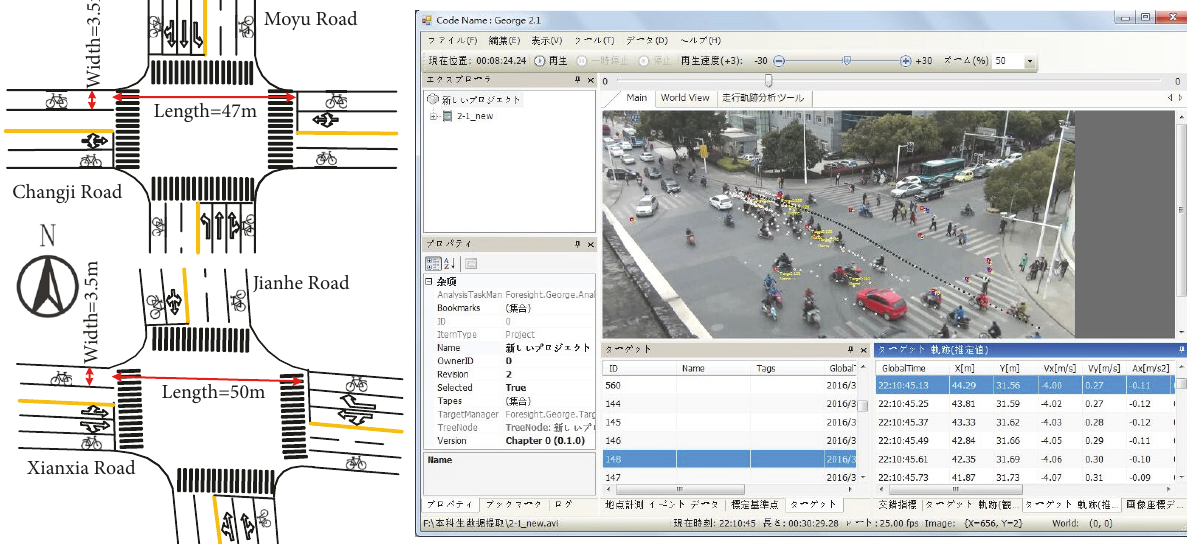
Figure 2: Channelization design of the two intersections and a screenshot of the trajectory extraction software.